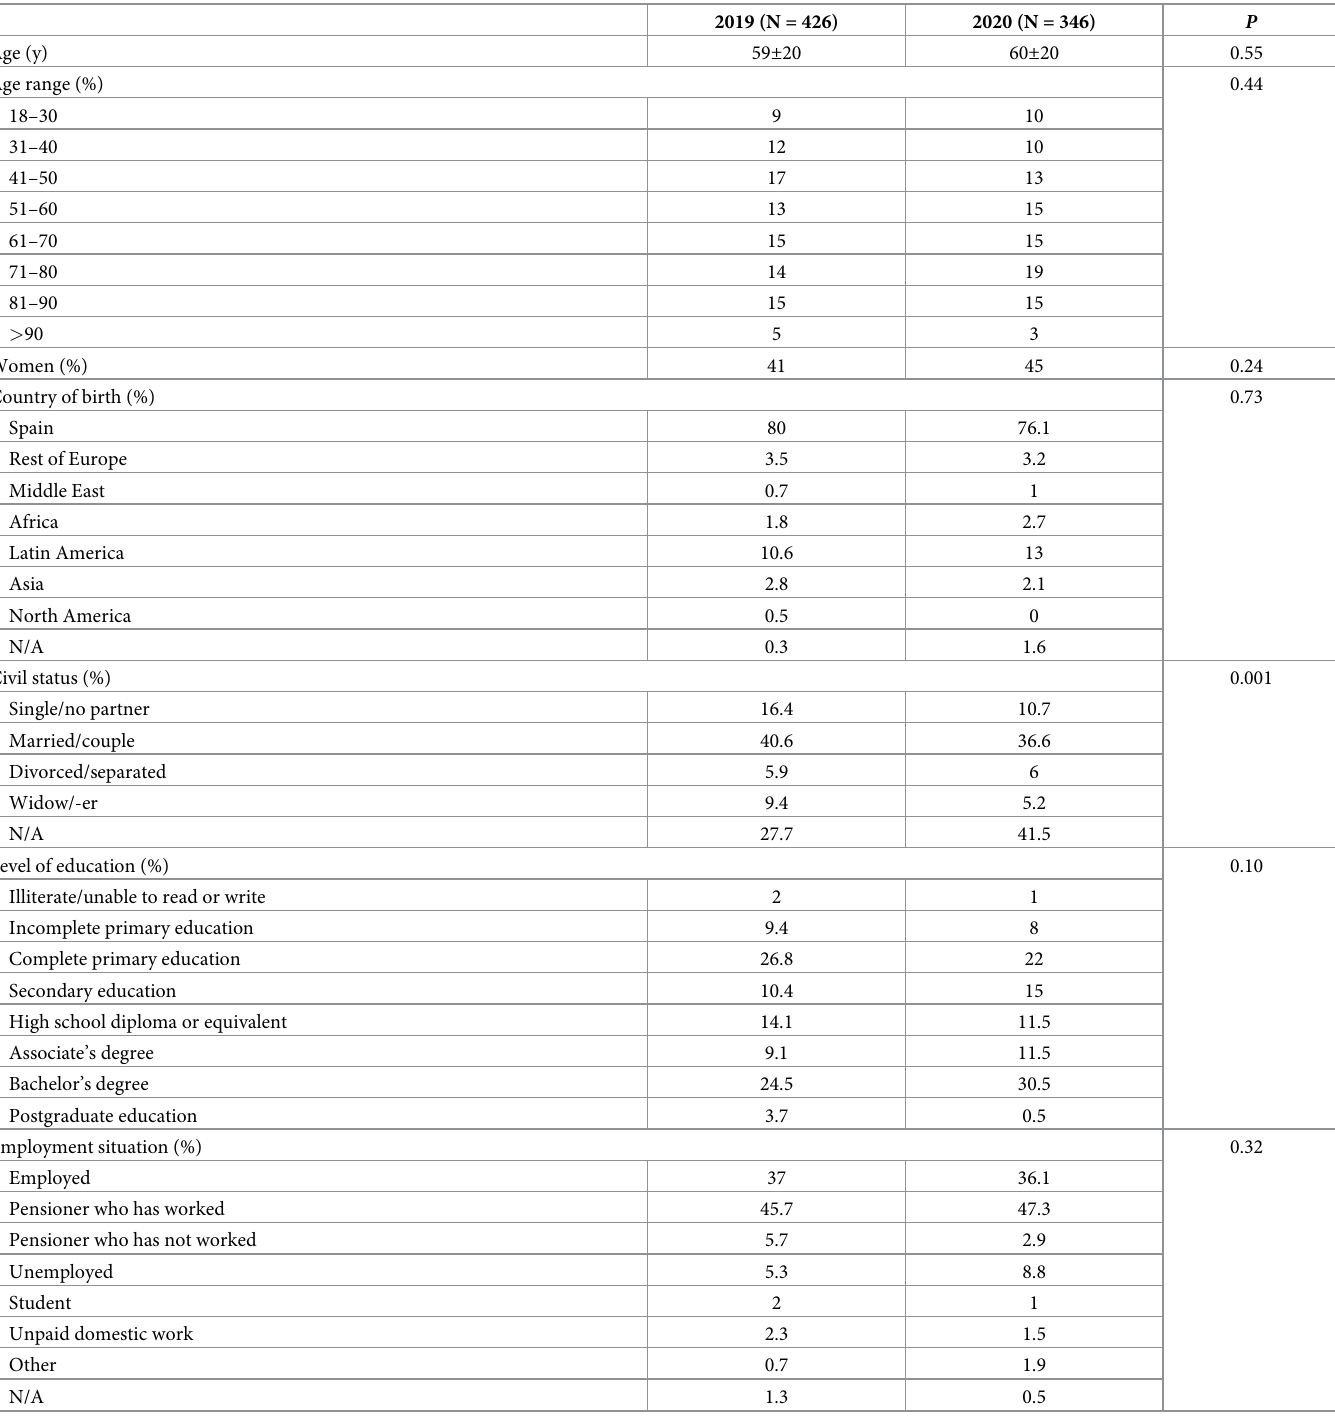
Table 1. Sociodemographic and clinical